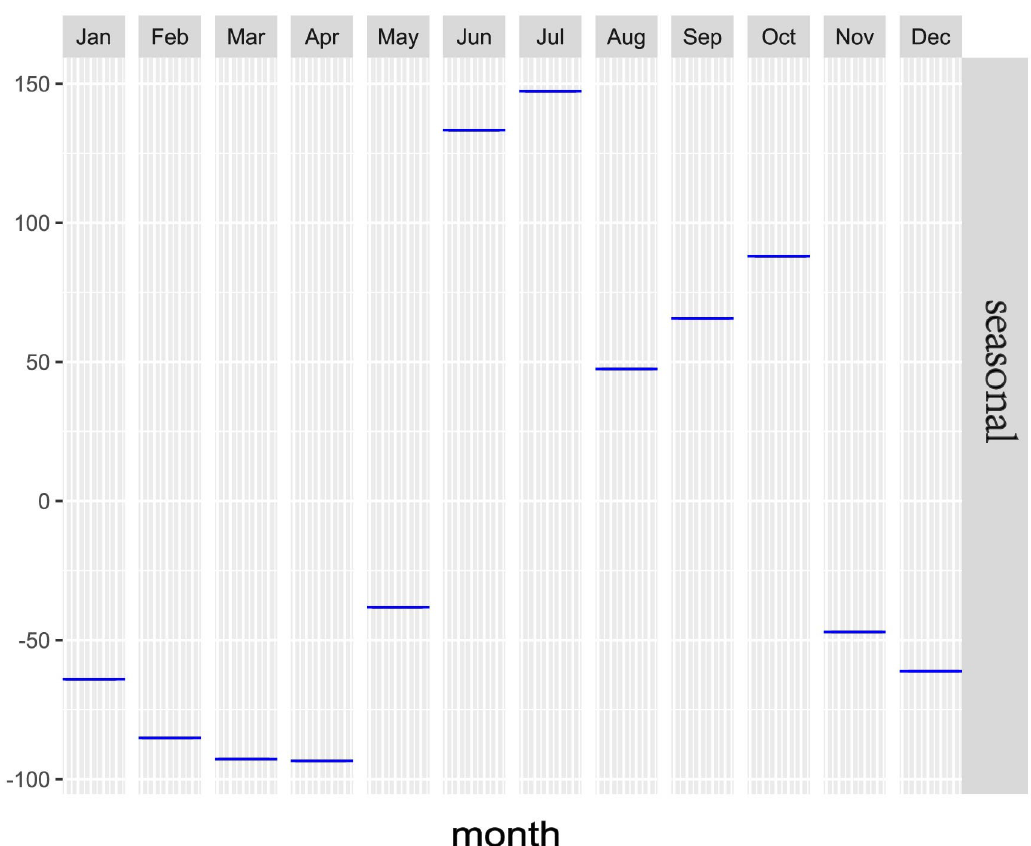
Fig 2. Seasonal subsequence from time-series analysis of reported monthly scrub typhus cases in Fujian Province, 2012–